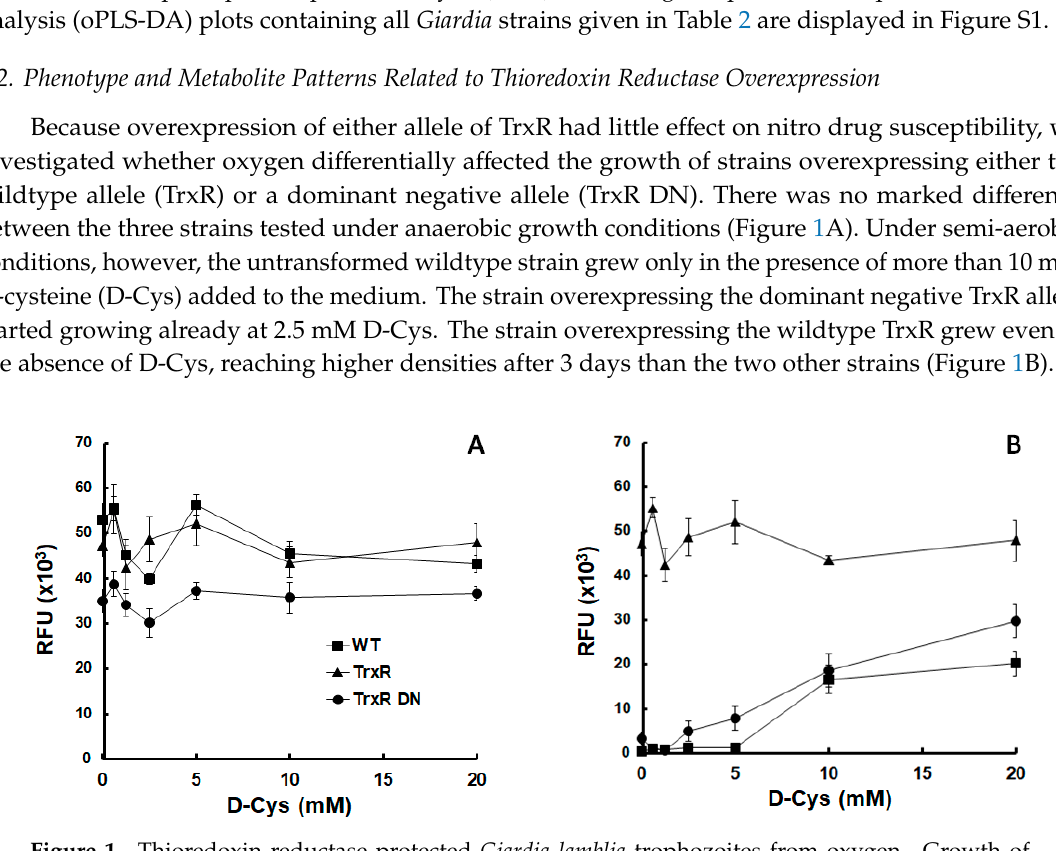
Figure 1. Thioredoxin reductase protected Giardia lamblia trophozoites from oxygen. Growth of G. lamblia wildtype trophozoites (WT) and of trophozoites overexpressing either wildtype thioredoxin reductase (TrxR) or a dominant negative mutant allele (TrxR DN) under anaerobic ( A ) or semi-aerobic ( B ) conditions in medium supplemented with different amounts of D-cysteine (D-Cys).